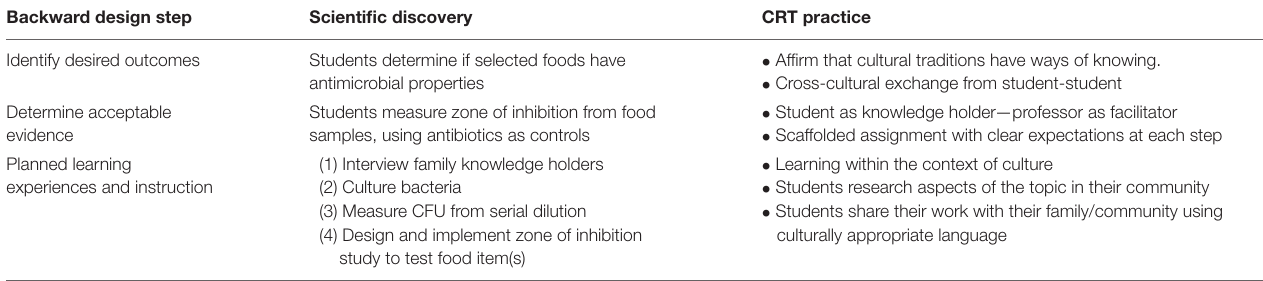
TABLE 1 | Example of mapping one outcome according to CURE Backward design process with embedded culturally responsive teaching (CRT)